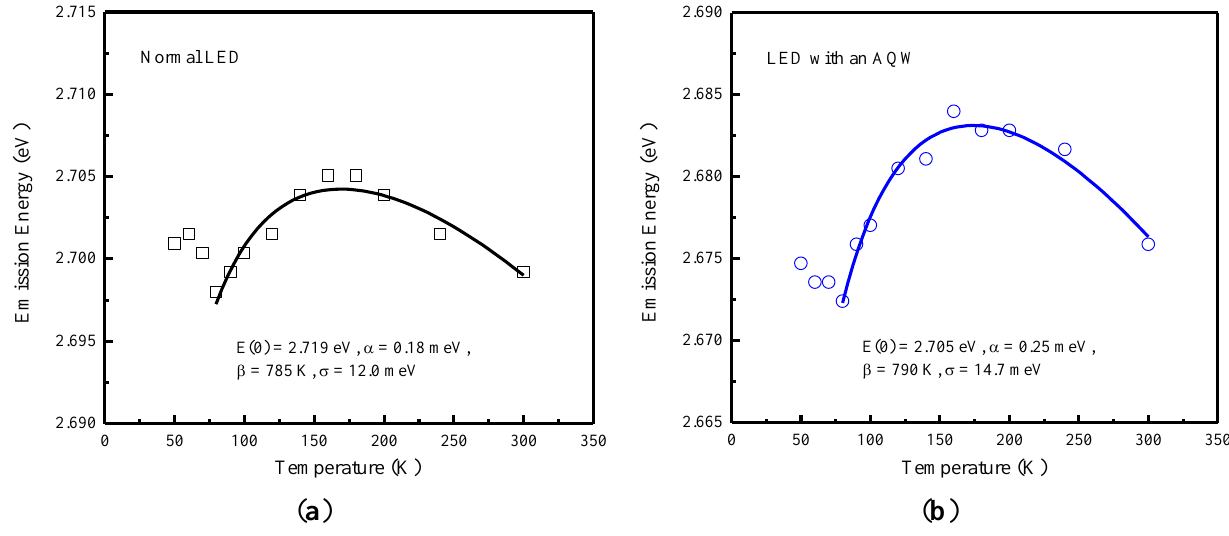
results of improved light output performance in the LED with an AQW, as compared to that of the normal LED. Figure 3. Temperature dependence of photoluminescence (PL) emission energy for ( a ) normal LED, and ( b ) LED with an AQW. The solid lines are fitted curves based on the band-tail model. The resulting fit parameters: E (0), α, β, and σ are 2.705 eV, 0.25 meV, 790 K, 14.7 meV, and 2.719 eV, 0.18 meV, 785 K, 12.0 meV, respectively, for the LEDs with and without an AQW.